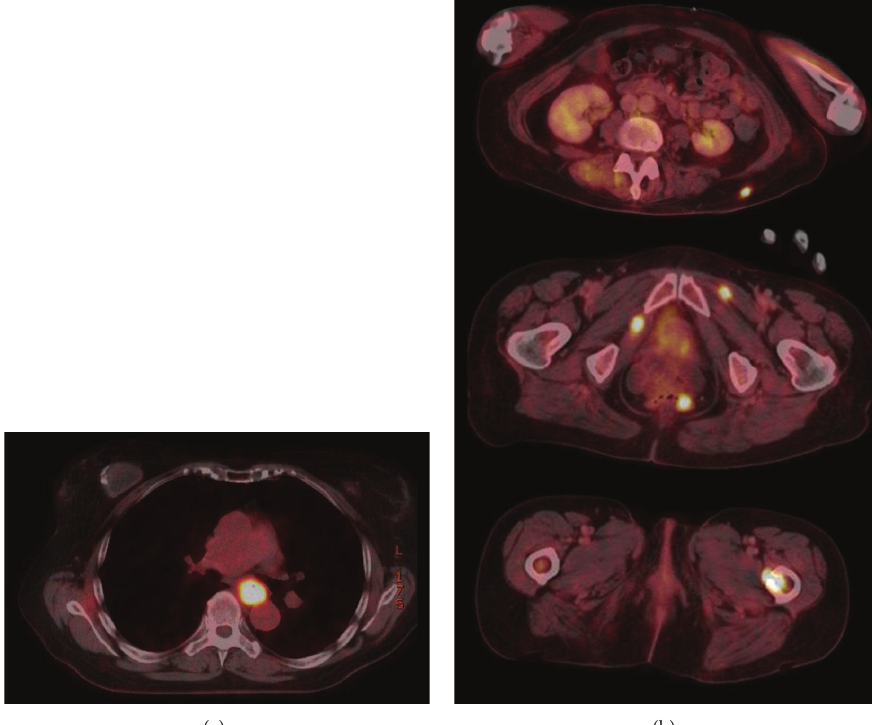
Figure3:(a)CombinedPET-CTscanwith283MbqF18FDGandcomputedtomographywithiodinebiasedcontrastagent.Areaofscreening: scull base till proximal femur. It reveals the large soft tissue mass with a significant increase in metabolic activity (SUV max 22.9) which surrounds the dorsal part of the thoracic esophagus. (b) Multiple cutaneous, muscular, and osseous metastases (SUV max 22.9) in the entire range of